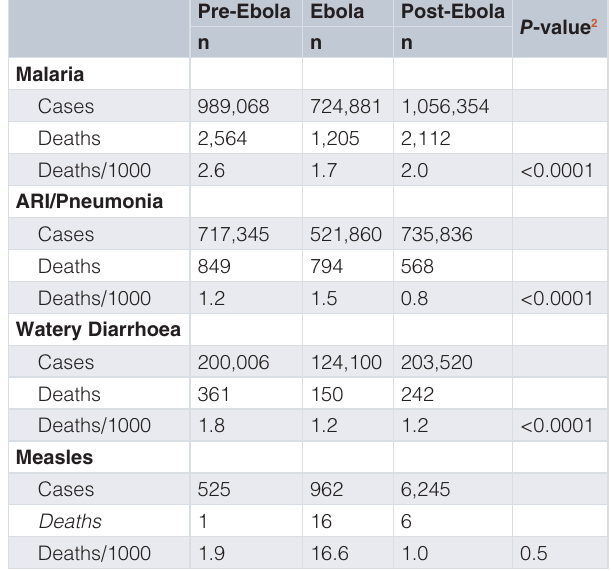
Table 2. Morbidity and case-fatality for four under five morbidities before, during and after the Ebola outbreak in Sierra Leone 1